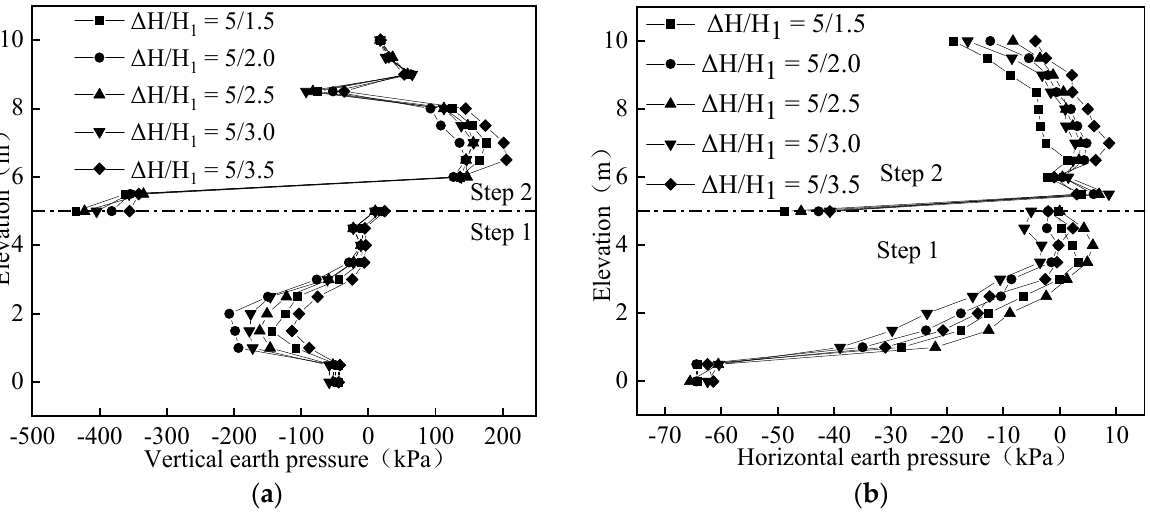
Δ : ( a ) vertical earth pressure; ( b )